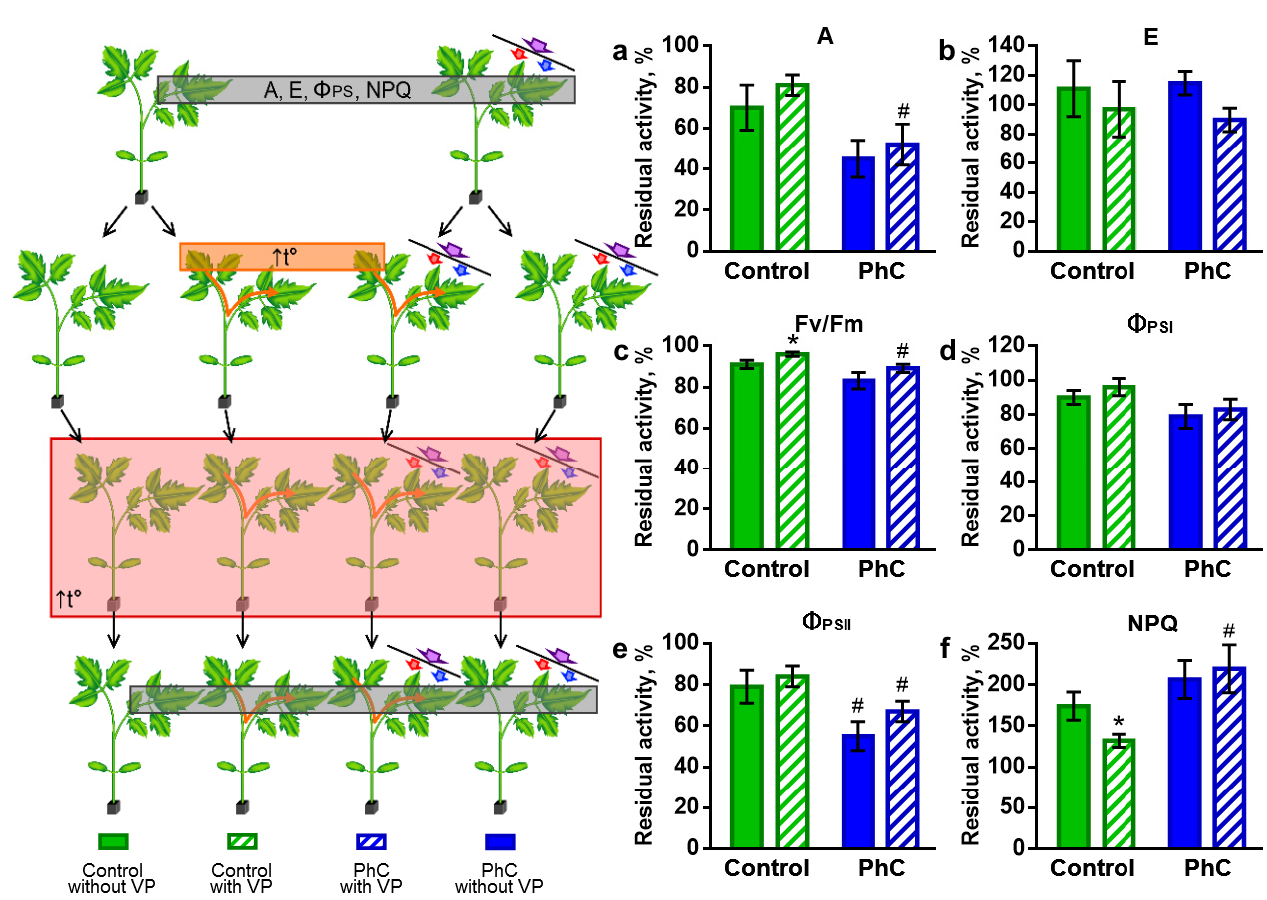
Figure 6. Influence of photoconversion coatings on electrical signal-induced resistance of tomato plants to heat stress, which was determined by the residual activity of physiological processes after heating: ( a ) residual activity of assimilation; ( b ) residual activity of transpiration; ( c – f ) residual activity of light-driven photosynthesis reactions. Residual activity is expressed in percentages, where 100% corresponds to the level before HS. The measurement scheme is shown on the left. Photosynthesis levels were first recorded (gray rectangle in the scheme); then, in half of the plants, ES was induced by short-term heating of the top leaf (orange rectangle and arrow in the scheme); after 45 min, all the plants were subjected to heat stress for 45 min at a temperature of 46 ◦ C (pink rectangle in the scheme). The residual levels of photosynthesis were recorded 1 h after heat stress. A: assimilation of CO 2 ; E: transpiration; F v /F m : efficiency of PSII photochemistry; Φ PSI and Φ PSII : quantum yield of photochemical reactions of photosystems I and II; NPQ: non-photochemical quenching of fluorescence; PhC: photoconversion. *: the difference between “without ES” and “with ES” is significant, p < 0.05; #: the difference between “control” and “photoconversion” is significant, p < 0.05.